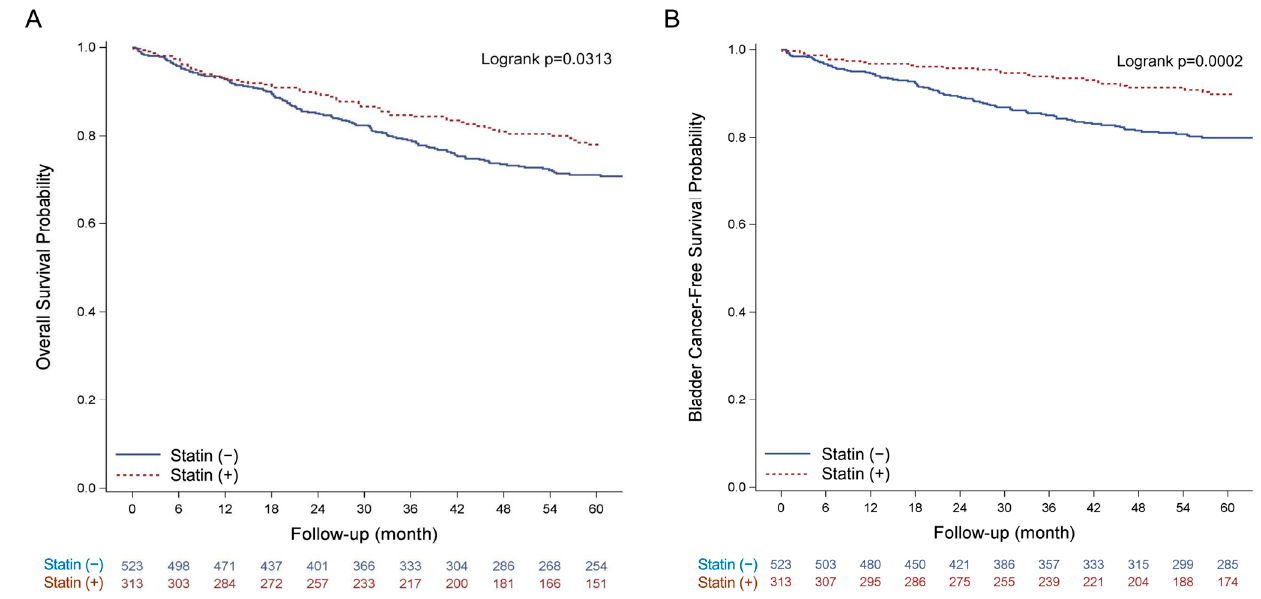
Figure 8. Kaplan–Meier plot of stage 0–I bladder cancer mortality with statins versus without. ( A ) all-cause mortality; ( B ) bladder cancer-related mortality.